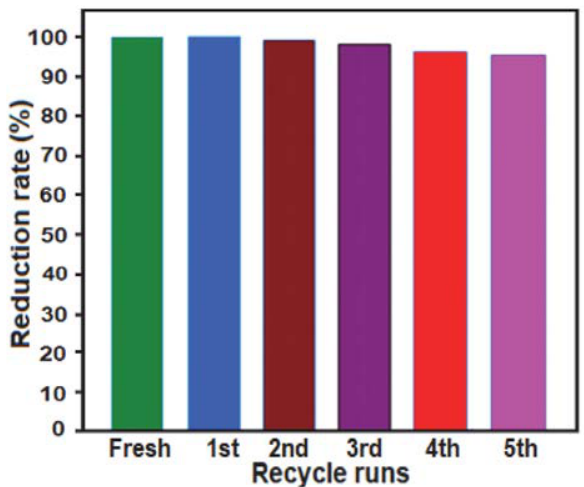
Figure 14. Recyclability of the of Bi 2 O 2 CO 3 /CoFe 2 O 4 30% nano- composite in the reduction of 4-NP. Conditions: catalyst (5.0 mg), [4-NP] = 0.2 mM and [NaBH 4 ] = 20 mM, at 25